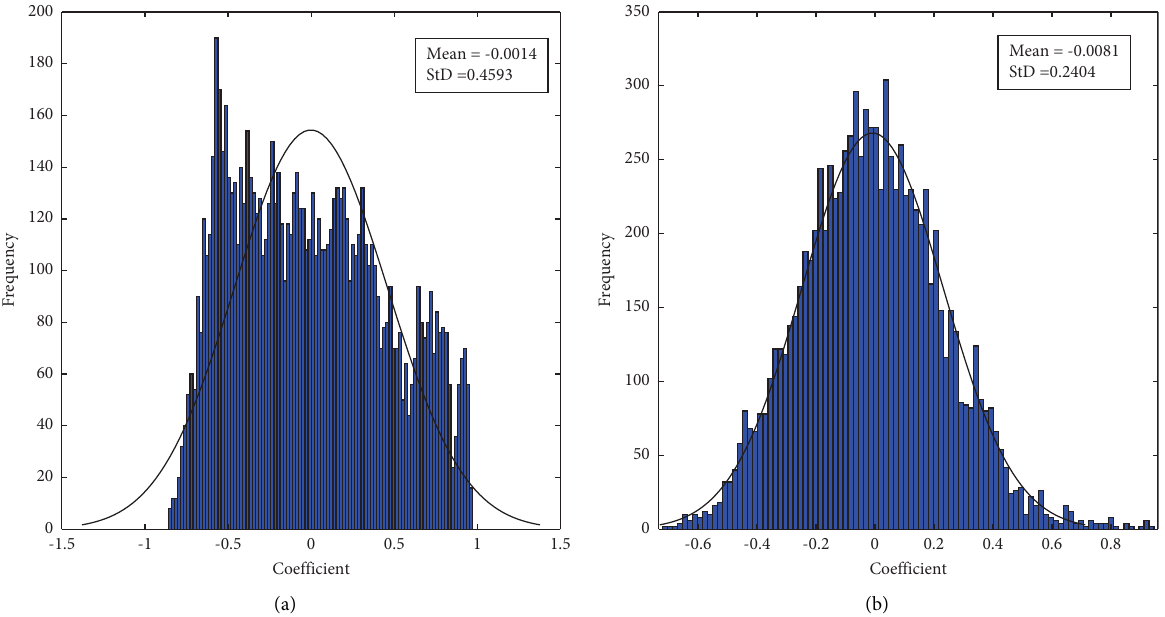
Figure 5: Histograms of correlation coefcients without the maximum eigenvalues and without the eigenvalues beyond the prediction range. (a) Histogram of the distribution of correlation coefcients without the maximum eigenvalue and (b) histogram of the distribution of correlation coefcients without the maximum eigenvalues beyond the prediction